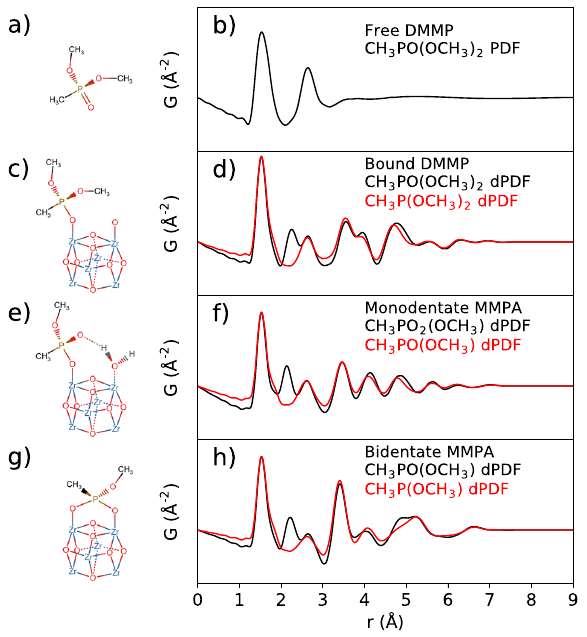
Fig. 5 DFT structures and corresponding difference PDFs. Schematic representations and simulated PDF for isolated DMMP molecule a , b , and difference PDFs (dPDFs) representing DMMP + DMMP-cluster pair distances, for c , d bound DMMP, e , f monodentate MMPA, and g , h bidentate-bound MMPA. Red curves show the dPDFs with bridging oxygen considered as part of the cluster.